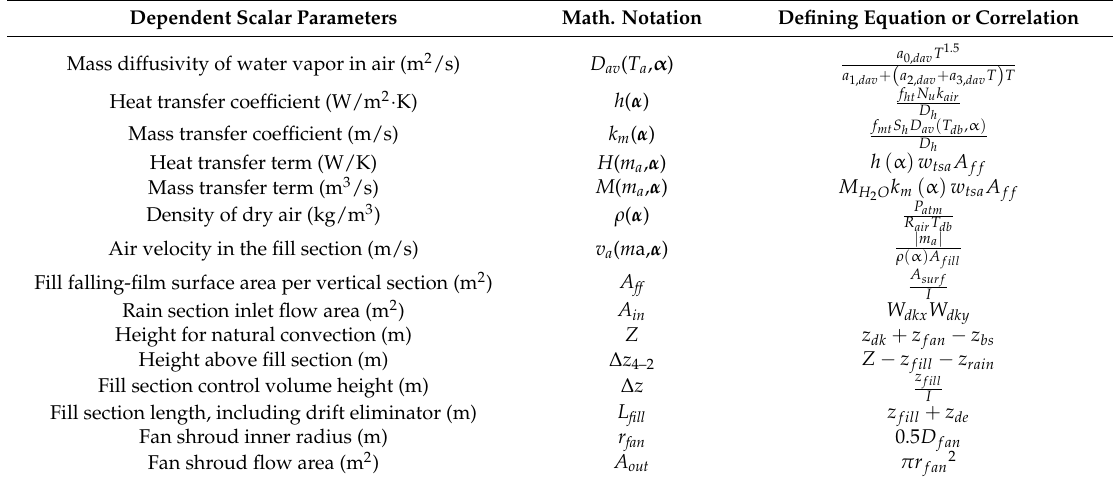
Table A2. Dependent scalar model parameters.